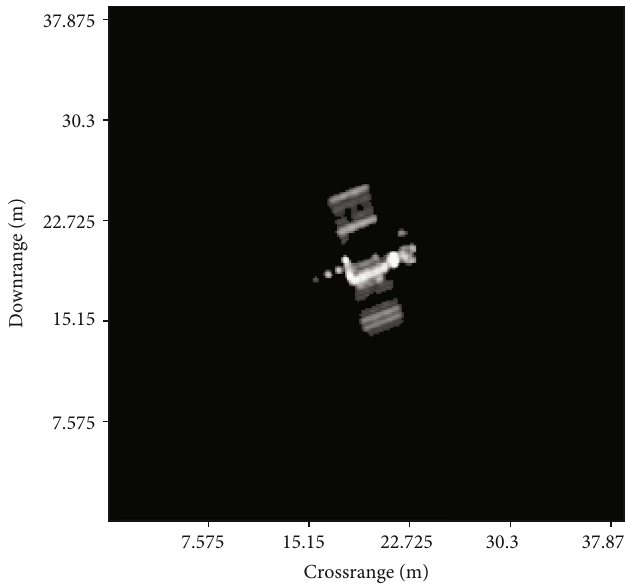
Figure 2: ISAR image of the target satellite after segmentation and normalization.